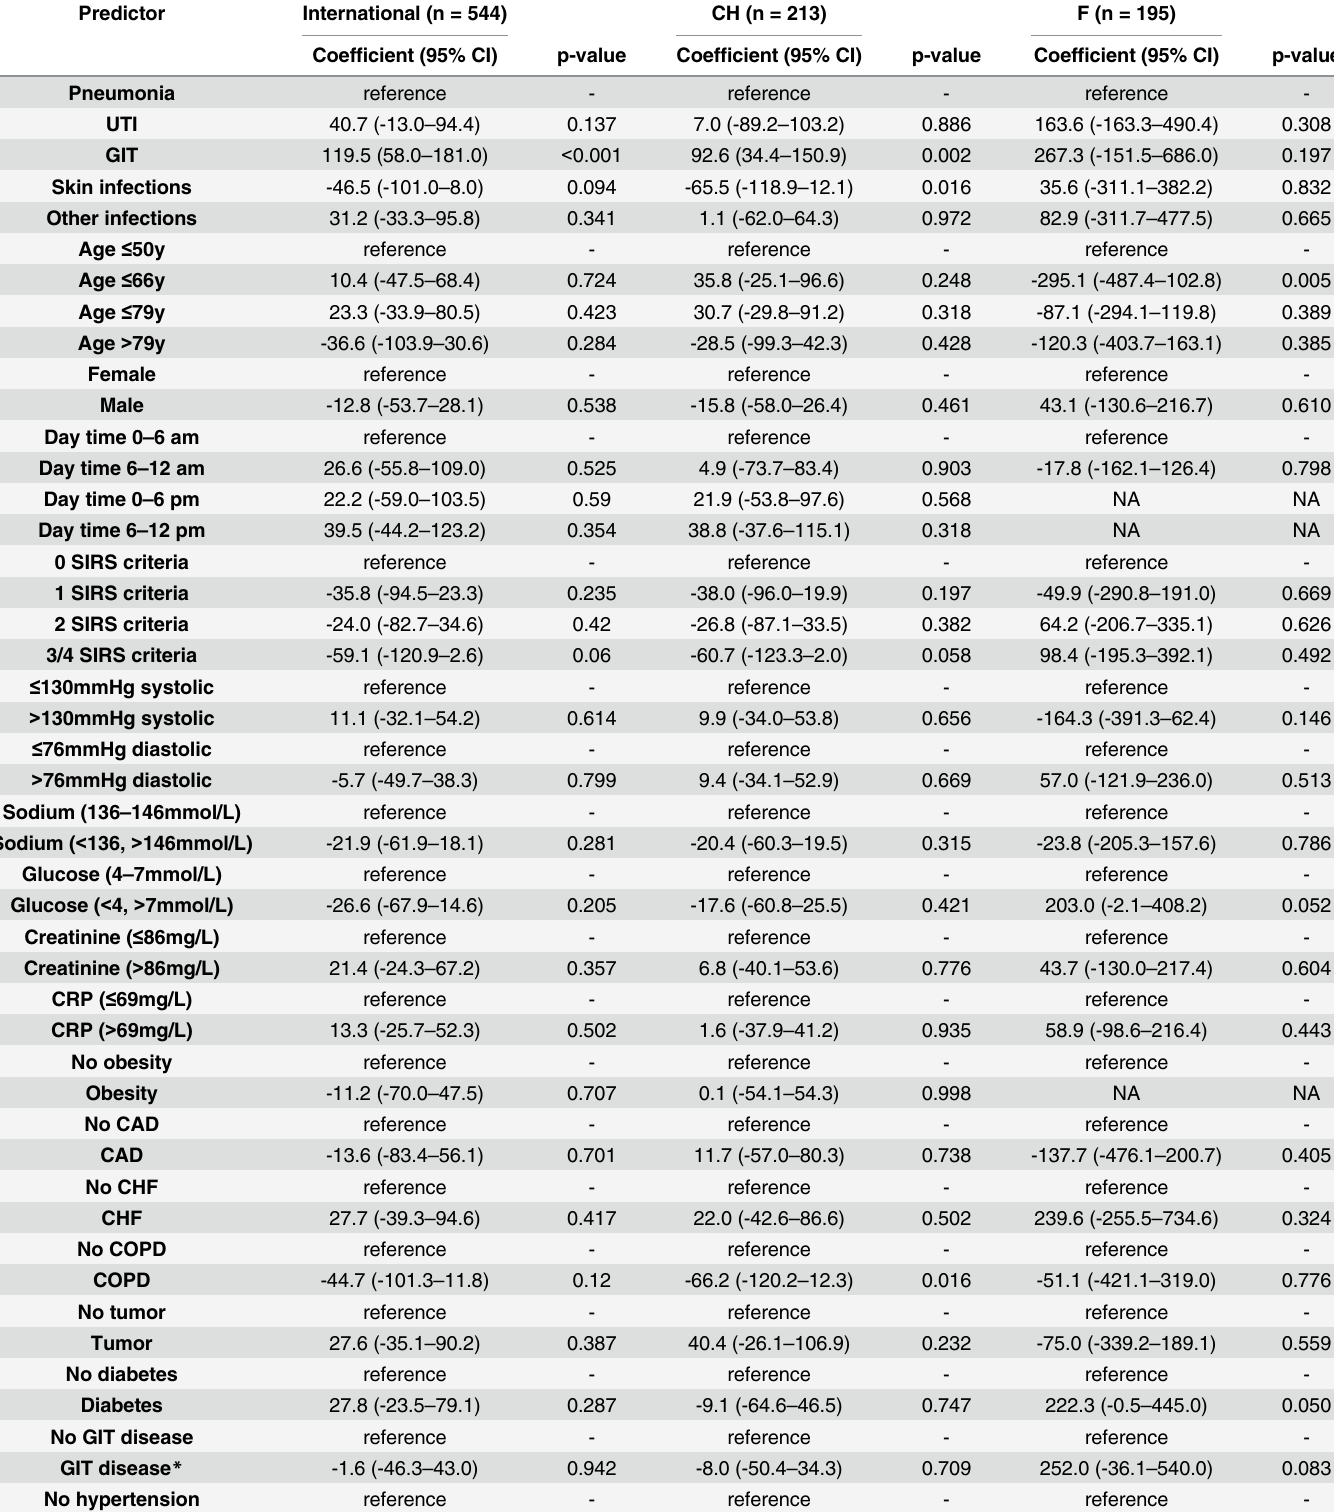
Table 3. Predictors of delayed antibiotic drug